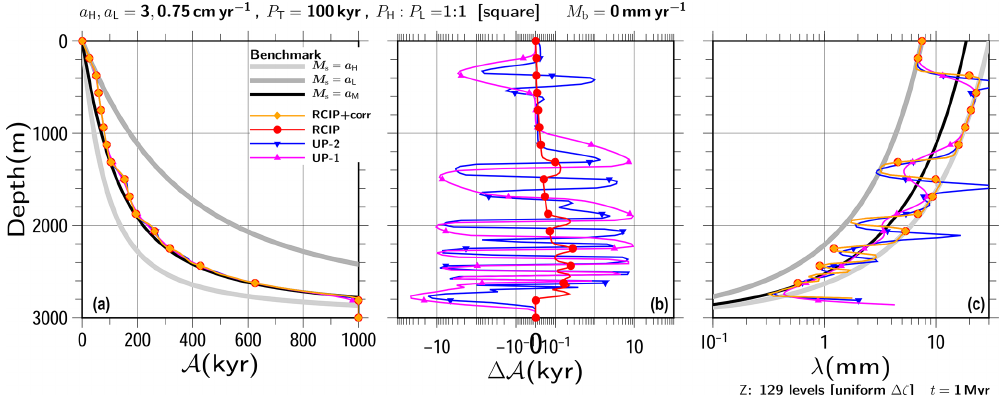
Figure 8. Same as Fig. 7 but for the results of transient experiments using a square-wave surface mass balance of a L = 3 and 0.75cmyr − 1 .